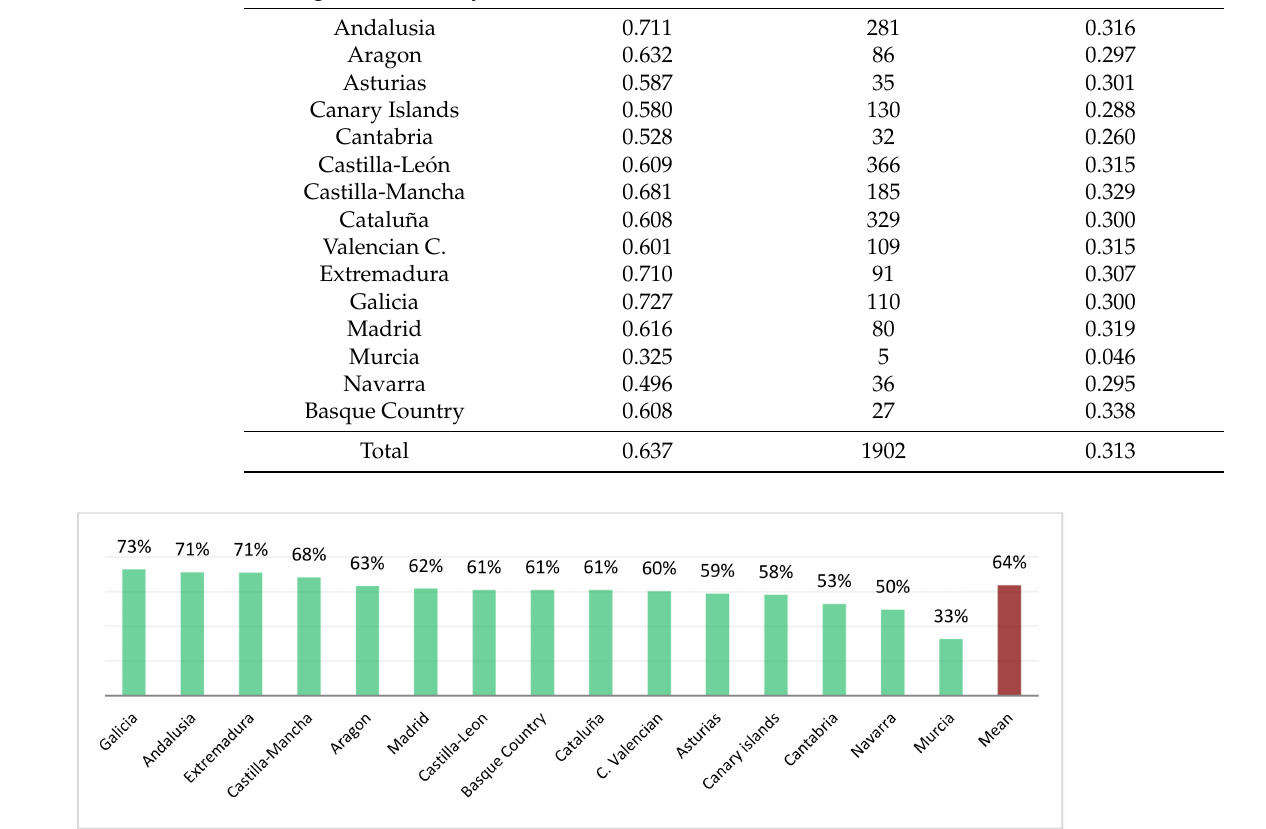
Figure 7. Regional efficiency ranking for rural